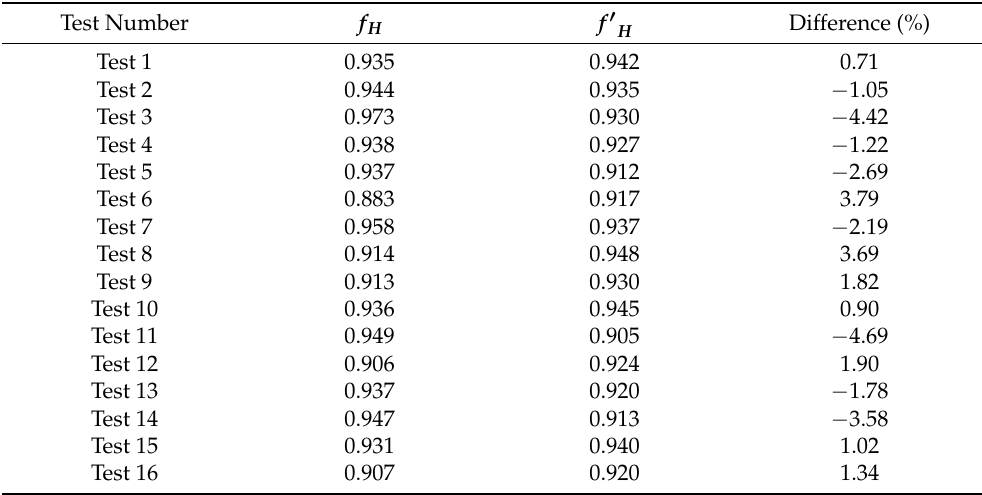
Table 12. Comparison between the reduction factors of horizontal stiffness from fitted expressions and finite element analyses.